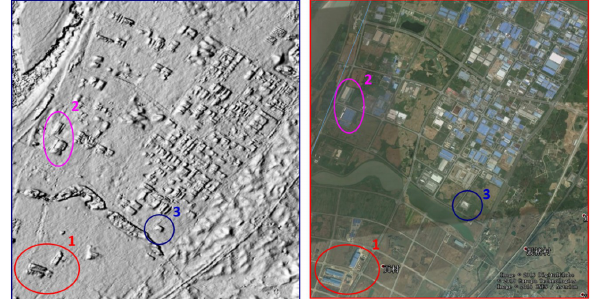
Figure 7 Comparison of DEM model from this experiment with Google image.